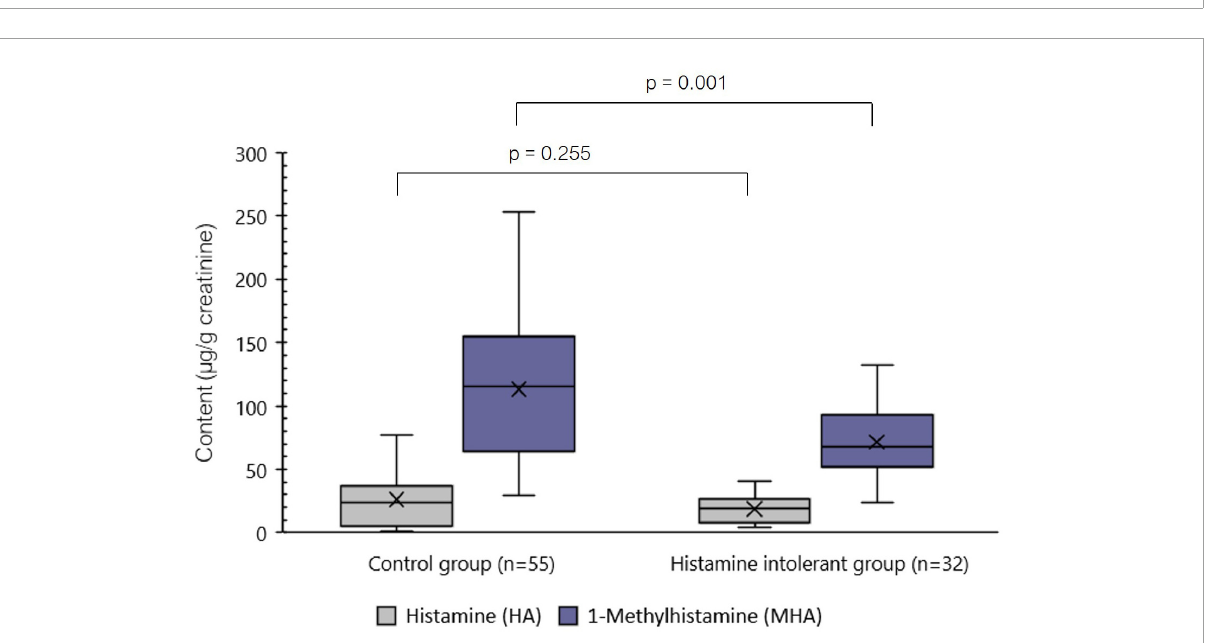
FIGURE2 Distribution of the levels ( µ g/g creatinine) of histamine (HA) and 1-methylhistamine (MHA) in spot urine samples of control and histamine intolerant individuals. p < 0.05 indicates statically significant differences in the urinary content of the analytes between study